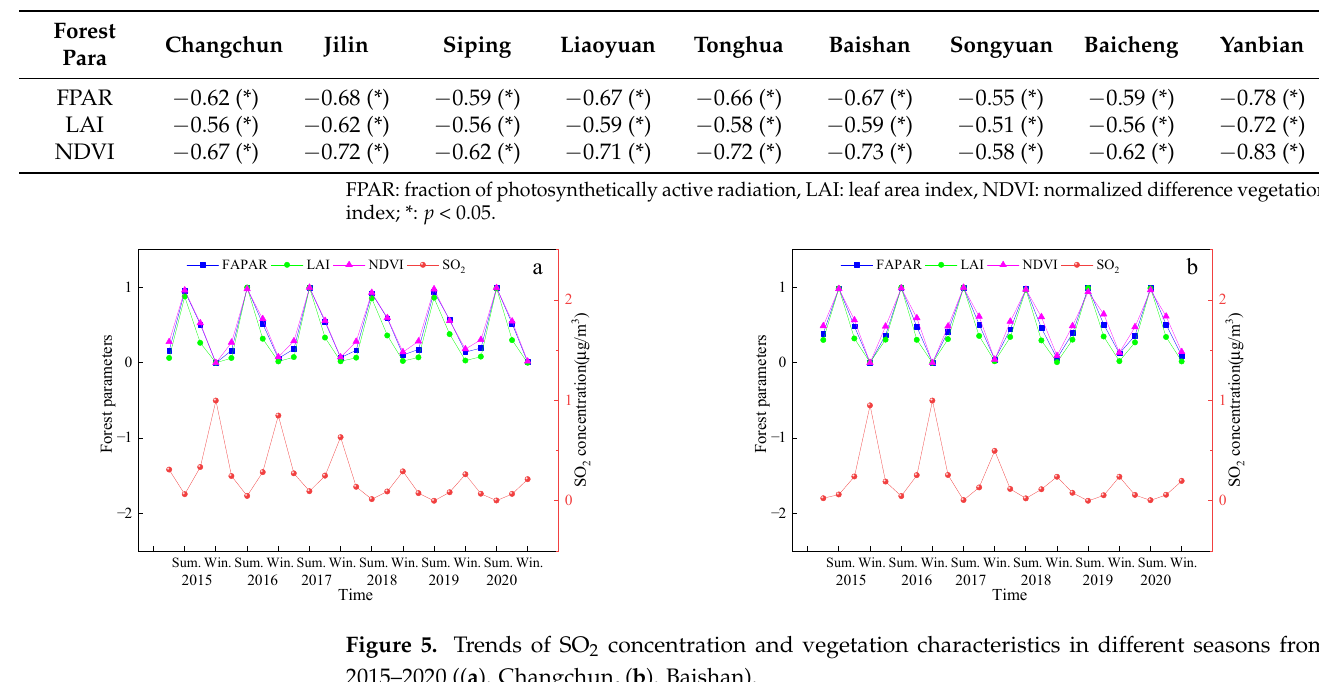
Table 9. Relationship between domestic, industrial SO 2 emissions and vegetation characteristic values in